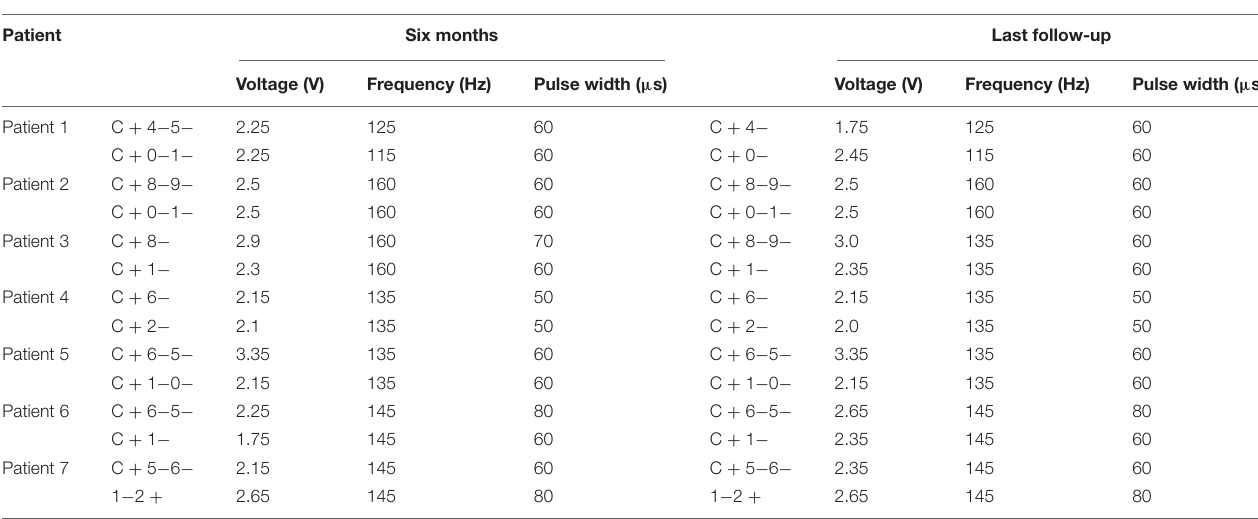
TABLE 5 | Stimulation parameters at 6-month and last follow-up #